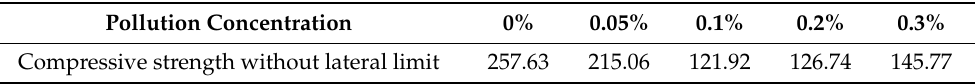
Table 2. Lateral limitless compressive strength of contaminated soil (kPa). Pollution